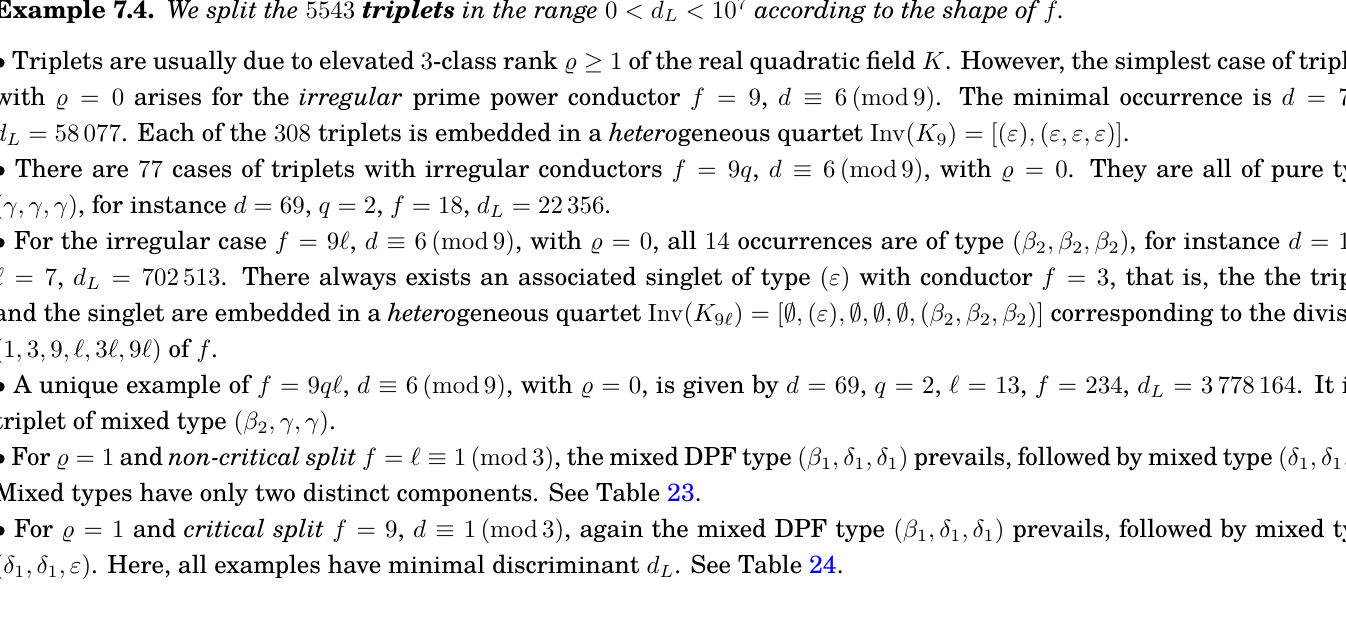
Table 15: Cyclic cubic discriminants d L = f 2 in the range 0 < d L < 10 7 .